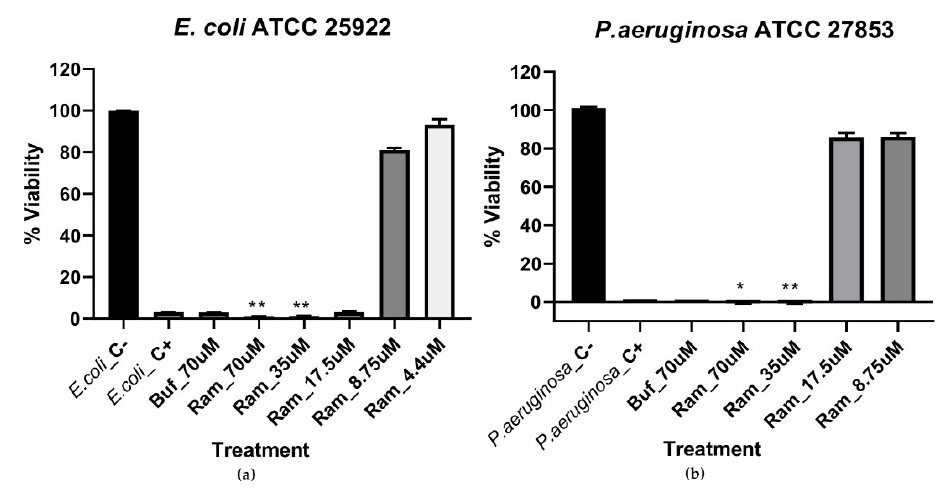
Figure 1. Endpoint assay to determine the viability percentage of Gram-negative bacteria after 19 h of treatment with Ramosin at concentrations of 4.37 µ M, 8.75 µ M, 17.5 µ M, 35 µ M, and 70 µ M by broth microdilution assay. ( a ) E. coli ( b ) P. aeruginosa . Buf: Buforin II. C − : bacteria without treatment C+: bacteria treated with NaClO 0.012%. Absorbance reading at 600 nm. Three independent experiments were carried out for each bacterial strain. Data are presented as mean ± SD. *: p < 0.05, **: p < 0.01.